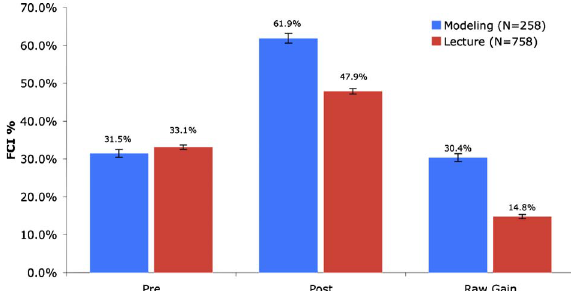
FIG. 3. (cid:1) Color (cid:2) Matched FCI Scores for MI and Lecture